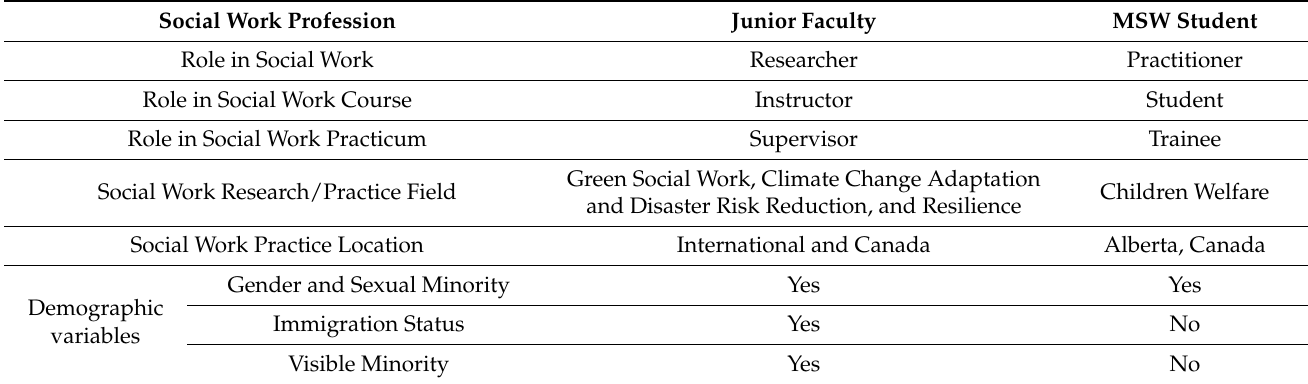
Table 1. Social work expertise and demographic